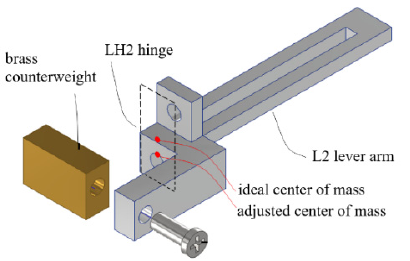
Figure 30. Design and construction of a balanced lever arm 2.